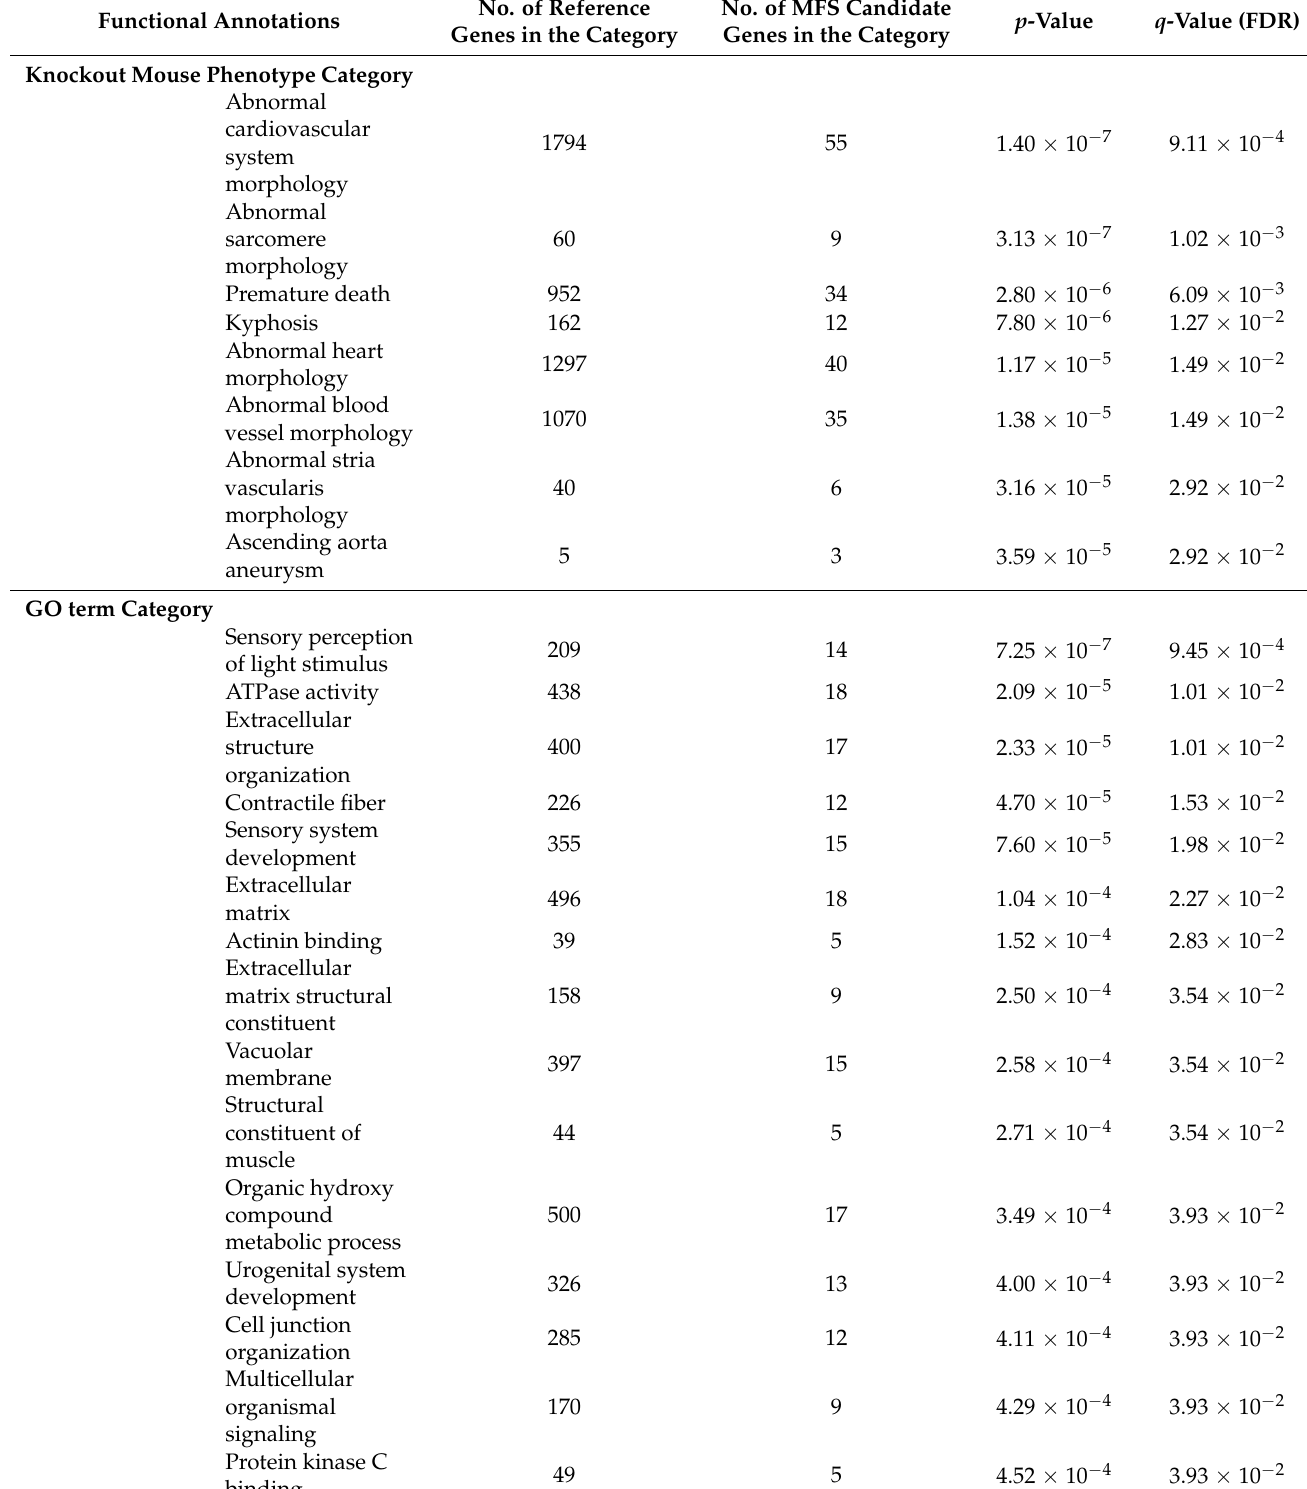
Table 3. Functional annotations of MFS candidate